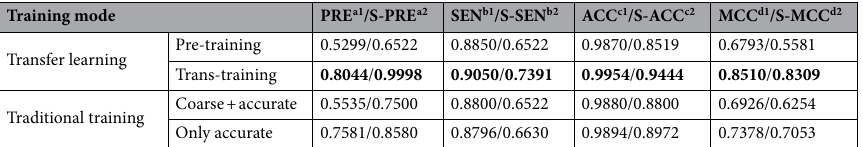
Table 3. Performance of RNA-par trained with different modes on TS dataset. The best performance was highlighted in bold. a1 precision, a2 segment-based precision, b1 sensitivity, b2 segment-based sensitivity, c1 accuracy, c2 segment-based accuracy, d1 Matthews correlation coefficient, d2 segment-based Matthews correlation